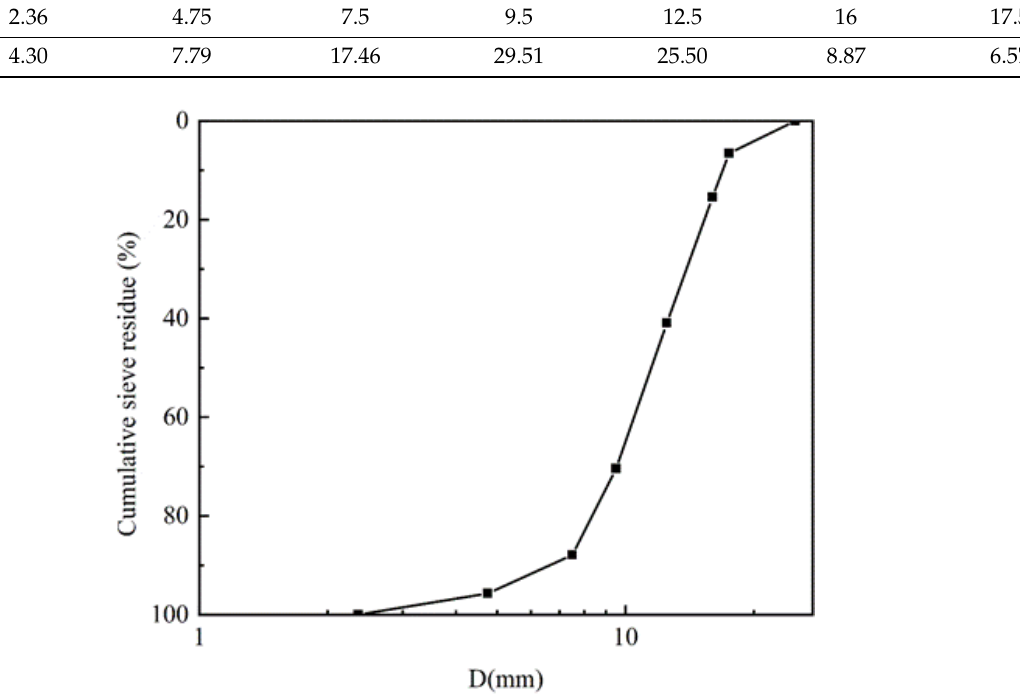
Figure 2. Grading curve of phase change aggregate. (The coordinates of the small squares indicate the cumulative sieve residue of the phase change aggregates at the corresponding size).